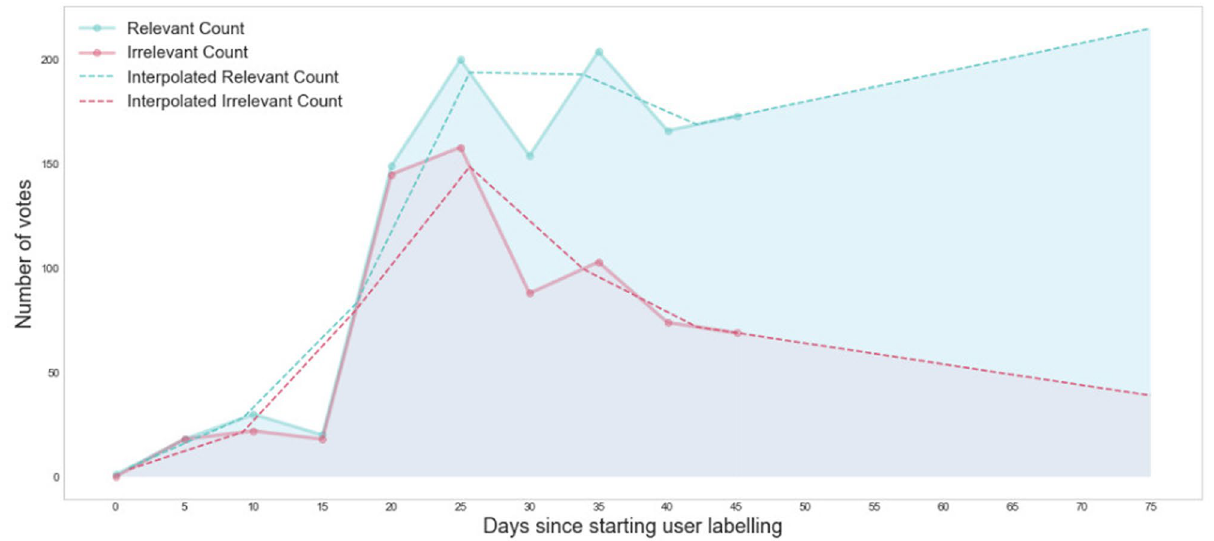
Figure 5. Analysis of natural language processing (NLP) pipeline. The graph shows relevance as a function of user feedback functionality in the app. Relevance is seen to increase with cumulative feedback over time. From day 0 onwards, the Relevant Count’s angular coefficient is 1.39 (± 0.488), the angular coefficient of Irrelevant Count is − 0.99 (± 0.602), with an average slope difference of about 2.29.